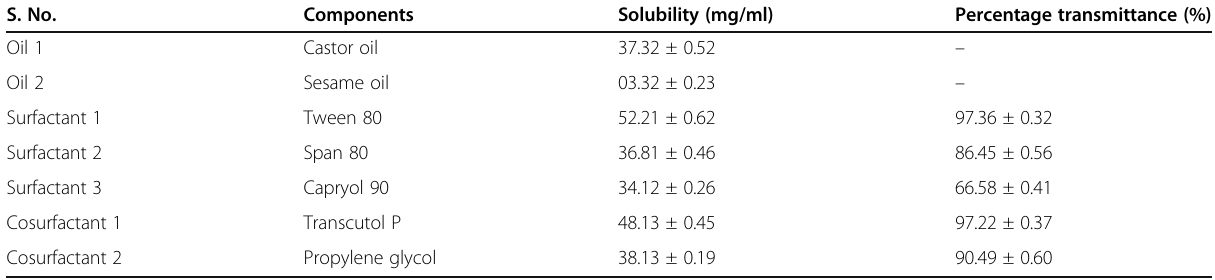
Table 1 Solubility of primaquine in various components at ~ 37 °C and percent transmittance for various surfactant and